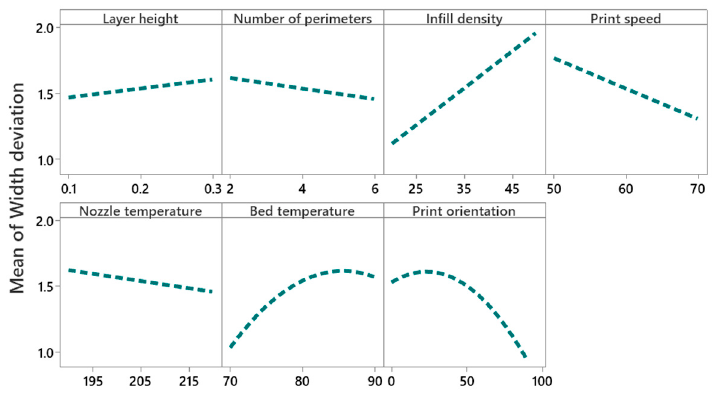
Figure 9. Main effect plot for width deviation.